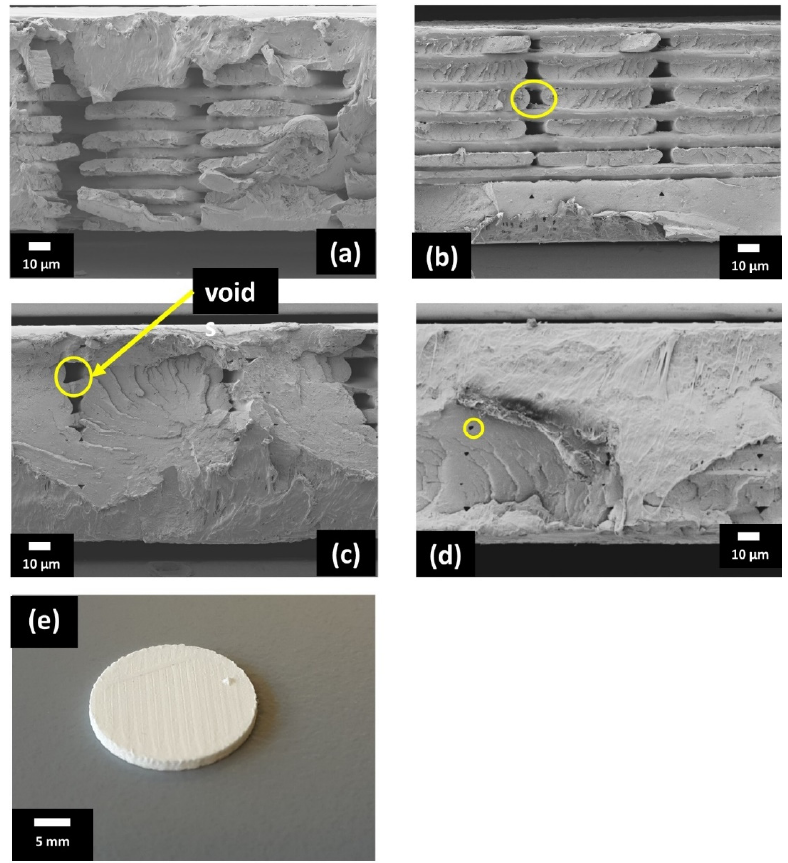
Figure 3. SEM images of cross-section of PLA-10 vol.% KNLN composite disc printed at: ( a ) 180 °C, ( b ) 190 °C, ( c ) 200 °C, ( d ) 210 °C, ( e ) 3D-printed composite disc.